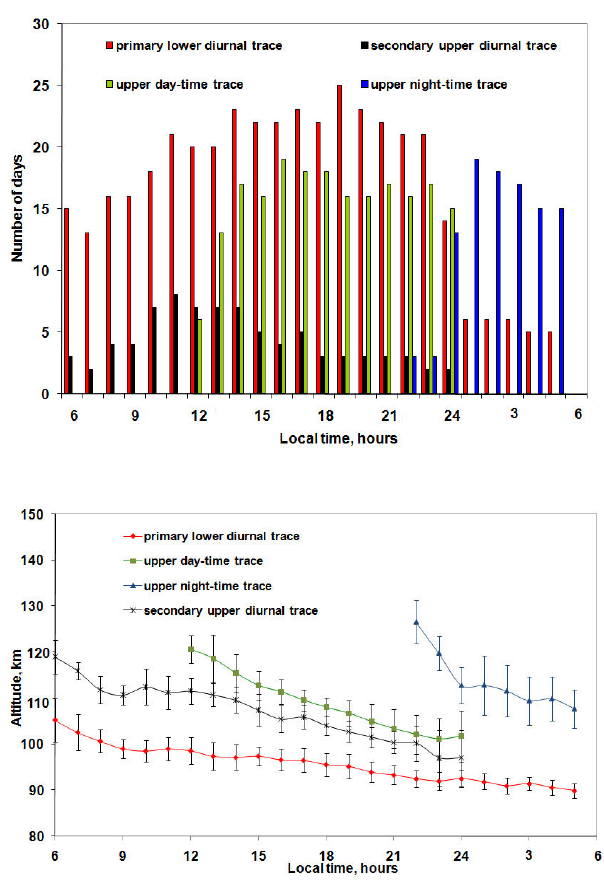
Fig. 7. Same as in Fig. 4 but for fall (September, October, Novem-